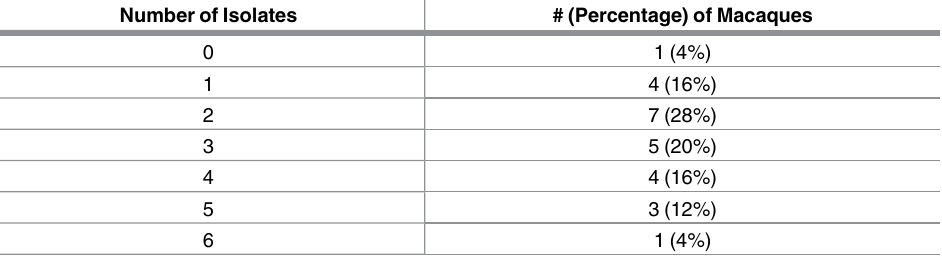
Table 4. The Majority of Macaque Chambers Display Polymicrobial Colonization.